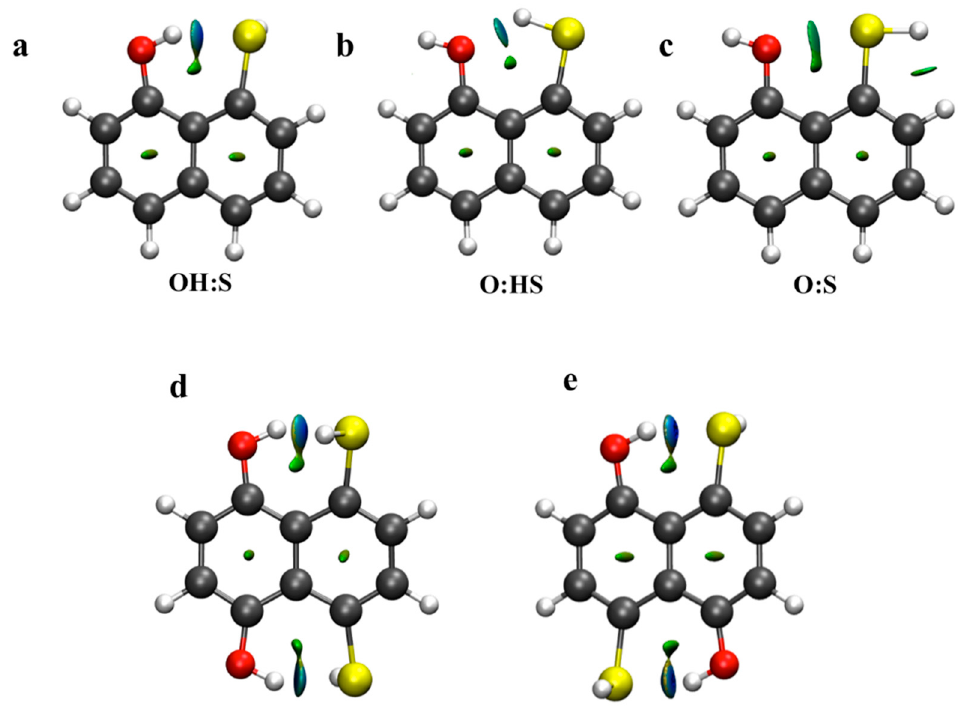
Figure 5. NCI plots of non-covalent interaction for complexes ( a ) OH:S , ( b ) O:HS , ( c ) O:S , ( d ) OH:S 14np and ( e ) OH:S 15np . Blue and green areas correspond to λ 2 > 0 (strongly attractive) and λ 2 ≈ 0 (weak) respectively. λ 2 is one of the three eigenvalues of the electron density Hessian with λ 1 ≤ λ 2 ≤ λ 3 .